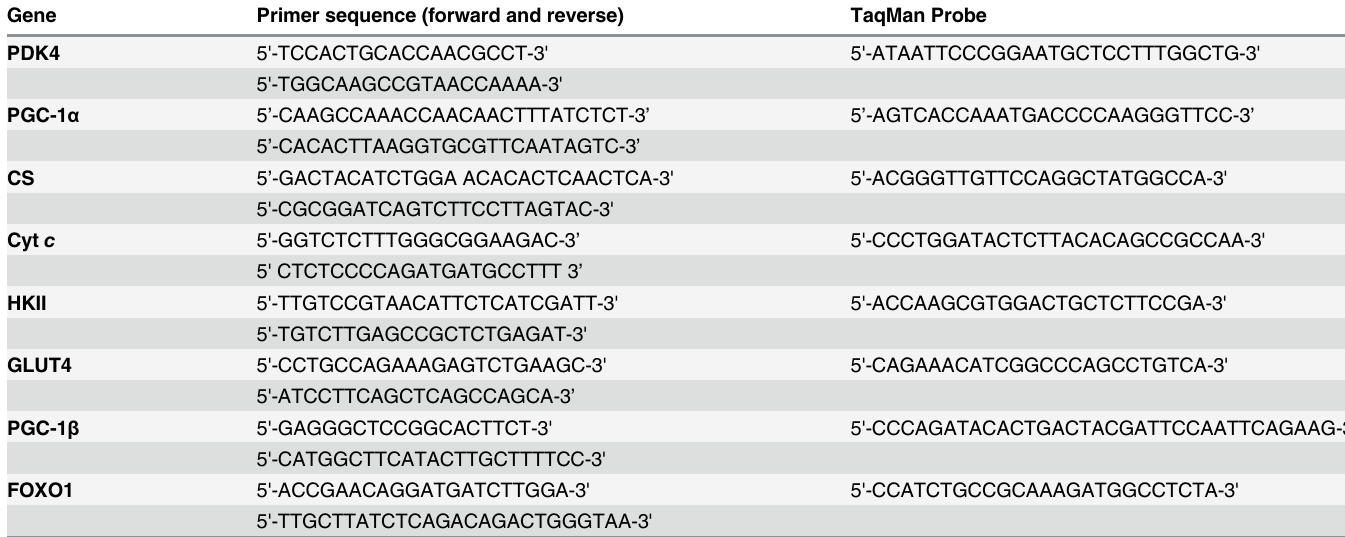
Table 1. Primer and TAQMAN probe sequences used for real-time PCR. PDK4, pyruvate dehydrogenase kinase 4; PGC-1 α , peroxisome proliferator- activated receptor- γ coactivator-1 α CS, citrate synthase; Cyt c , cytochrome c oxidase, HKII, hexokinase II; GLUT4, glucose transporter-4; PGC-1 β , peroxi-